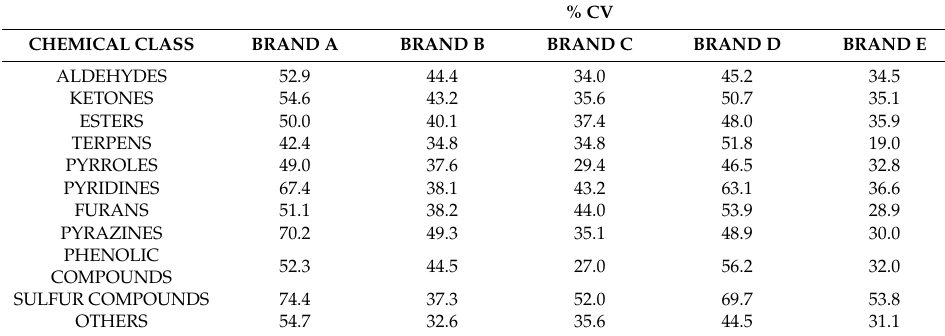
Table 3. Inter-brand variation (%CV) in the content of volatile compounds detected in EC samples by chemical class.